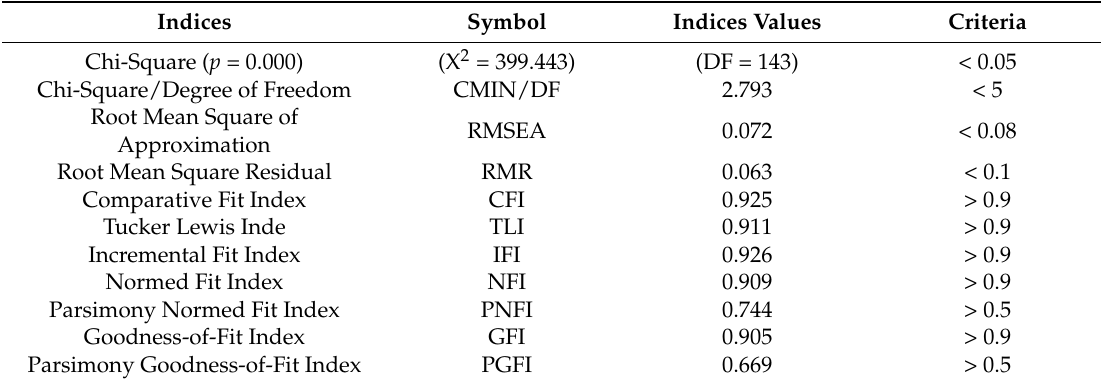
Figure 1. Exploratory factor analysis of measurement model. Table 7. Model fit